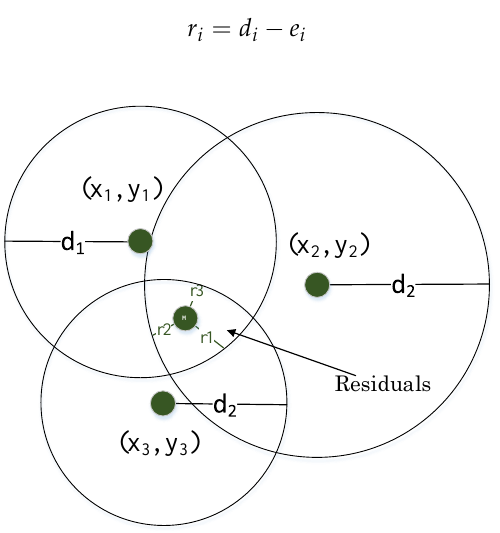
Figure 5. Residual values in trilateration